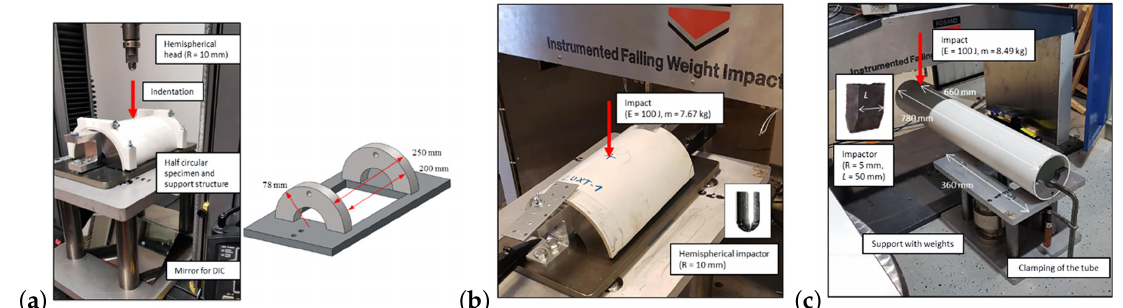
Figure 3. Testing of GFRP mechanics: ( a ) the QS indentation of a half-circular specimen with a semi-rigid boundary; ( b ) the drop-weight impact testing of a half-circular specimen with an ‘open’ boundary, and; ( c ) the drop-weight impact testing of a tubular pole